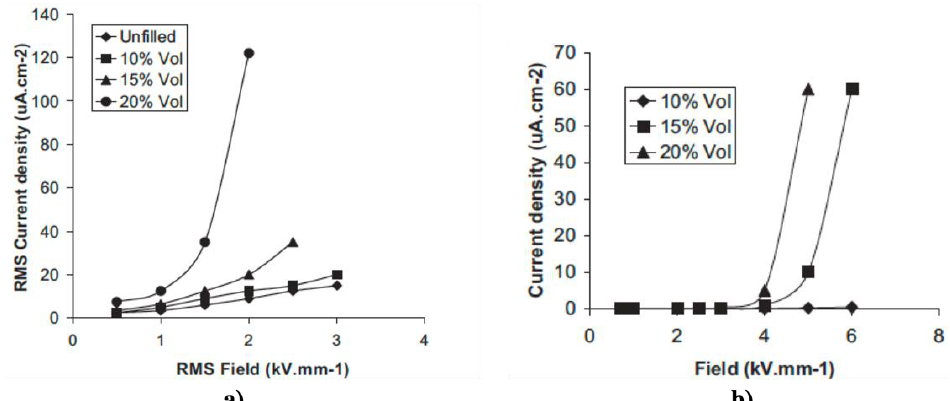
Figure 6. Current density versus electrical field strength for ZnO-filled epoxy resin. ( a ) AC and ( b ) DC. Republished with permission of Institution of Engineering and Technology (IET), from [45], © 2021; permission conveyed through Copyright Clearance Center, Inc.